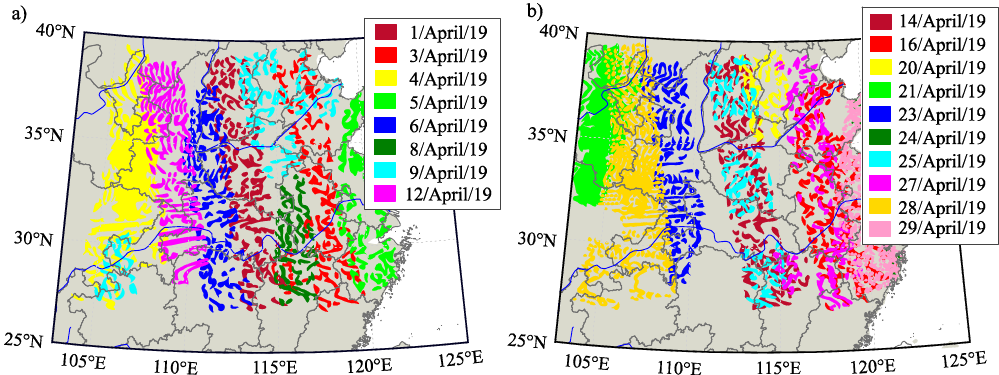
Figure 5. SMAP data for the periods ( a ) 1-12 and ( b ) 14-29 of April 2019 plotted at intervals of 500